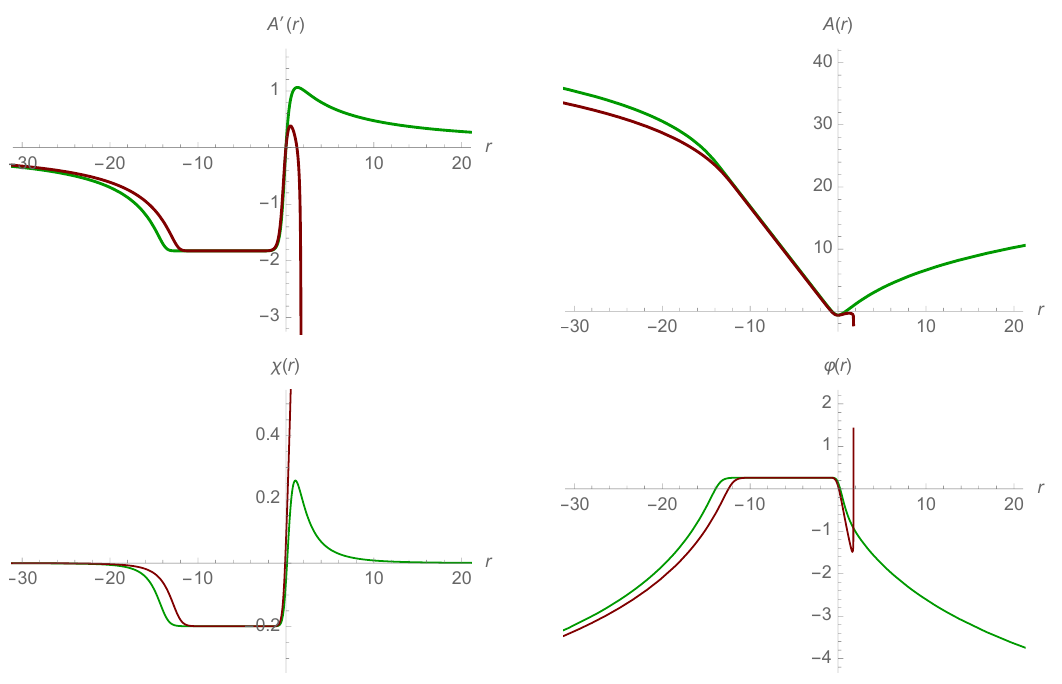
Figure 9. Examples of N = 1 SYM/ G 2 (green) and G 2 /singularity (dark red) Janus solutions with G 2